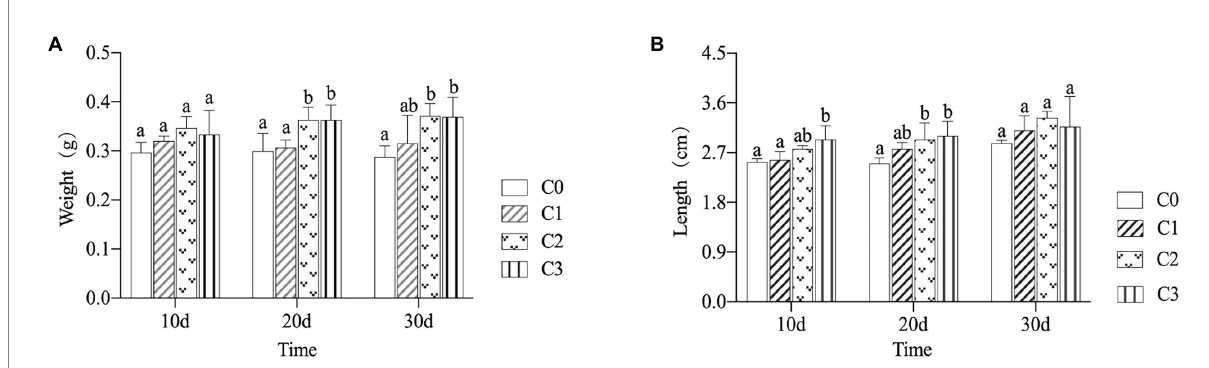
FIGURE 2 Effects of AVH-AgNPs on body weight (A) and length (B) of zebrafish. C0, C1, C2, and C3 refer to 0, 6, 9, and 18 μ g/l of AVH-AgNPs, respectively. Values are expressed as mean ± SE ( n = 3). Bars with different letters indicated significant differences ( p <